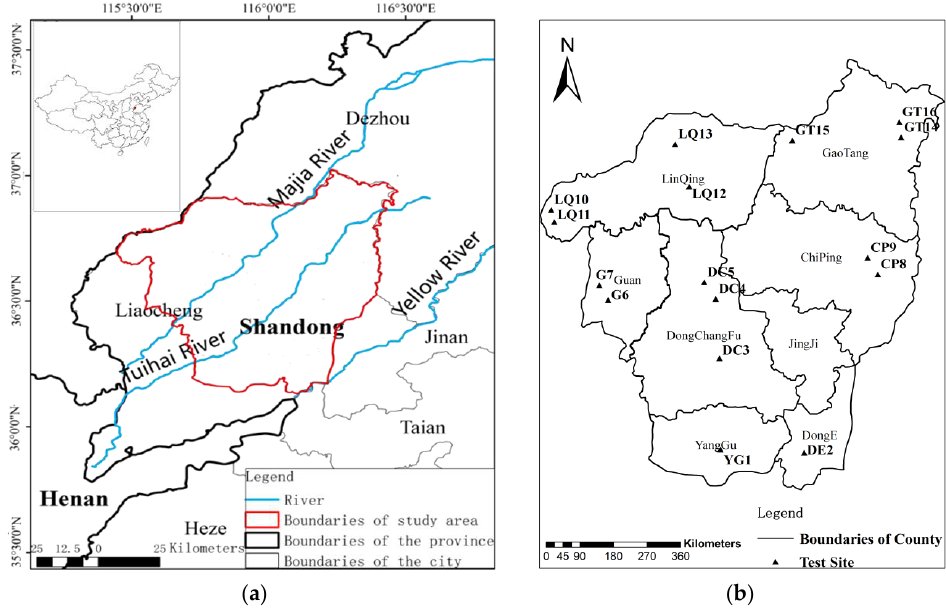
Figure 1. Location of the ( a ) study area and ( b ) sampling points and tracer injection. Table 1. Summary of bromide sampling points.